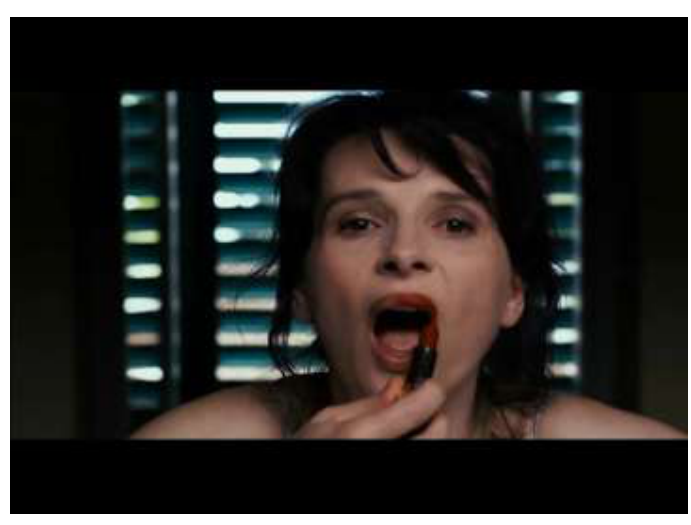
Figure 2: Framed by the window in the background, Elle applies lipstick while looking into the camera (a fictional mirror). It is unclear in this shot who is the object of the gaze—are we looking at her or vice versa?